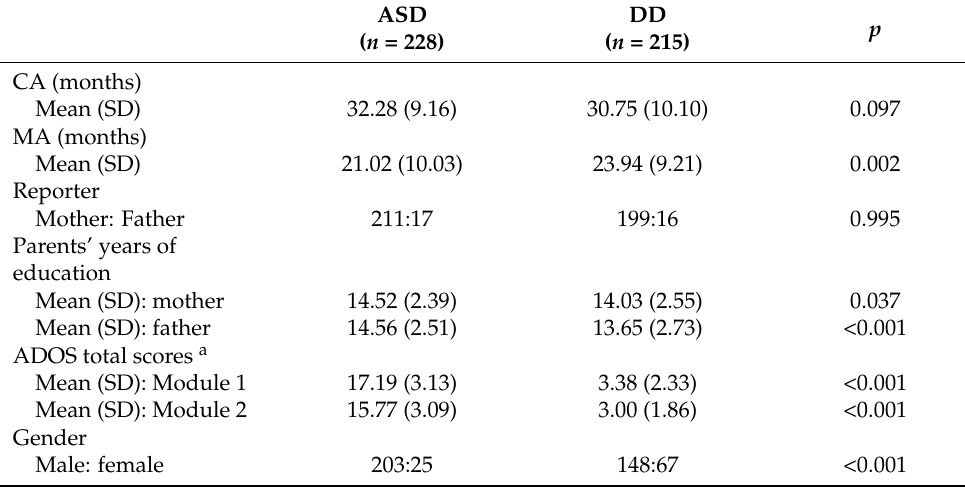
Table 1. The group comparison of background